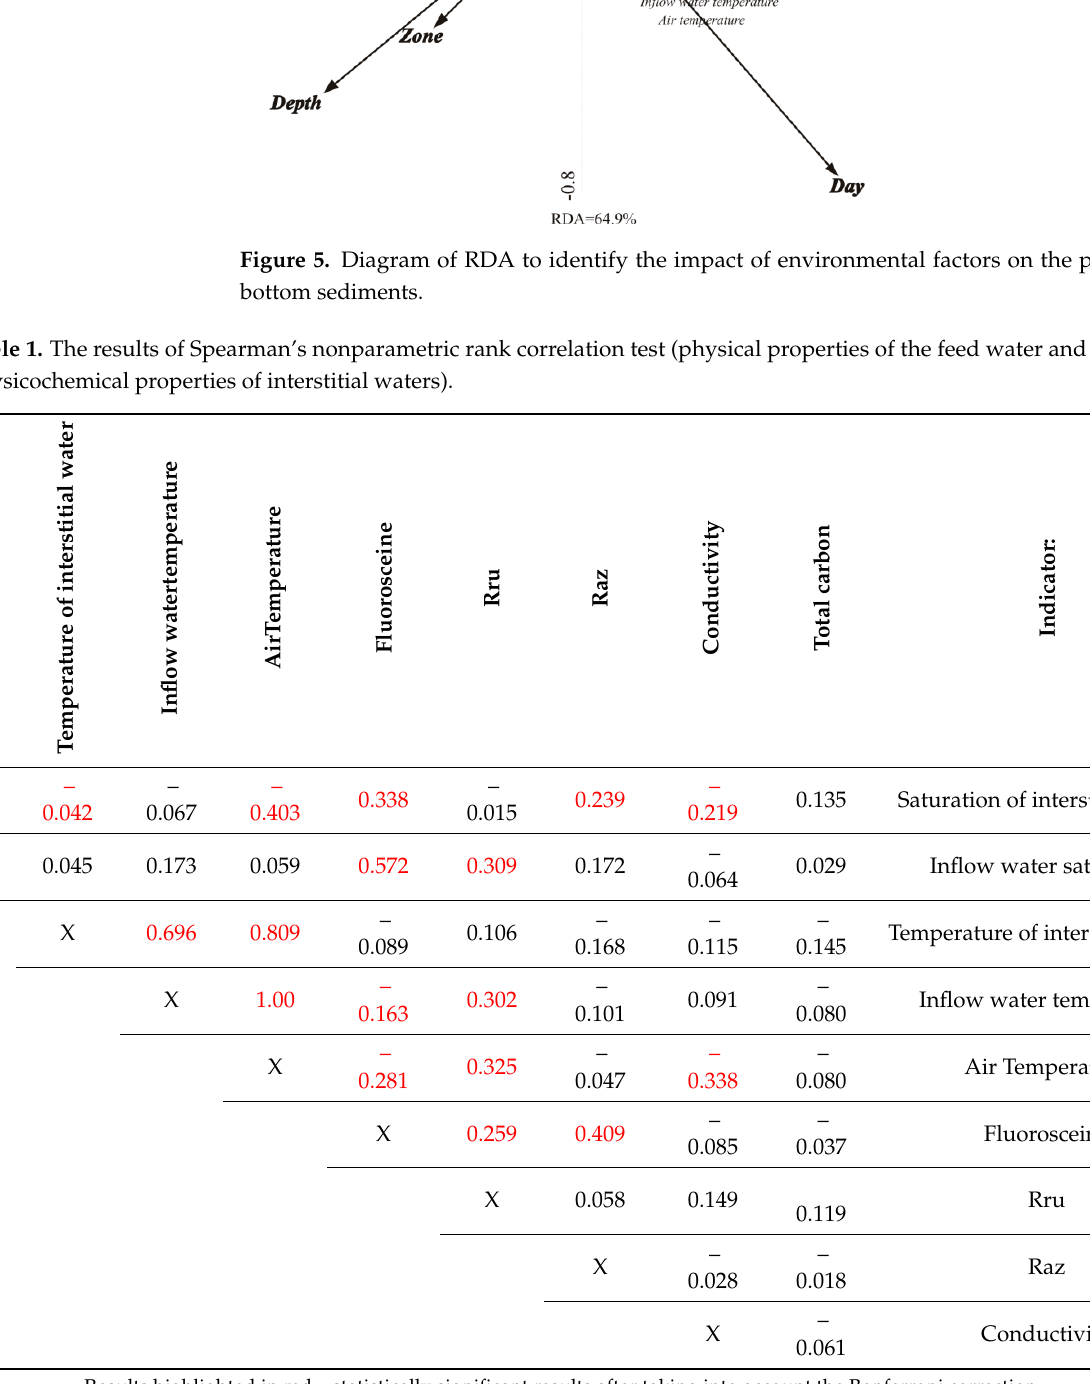
Results highlighted in red—statistically significant results after taking into account the Bonferroni